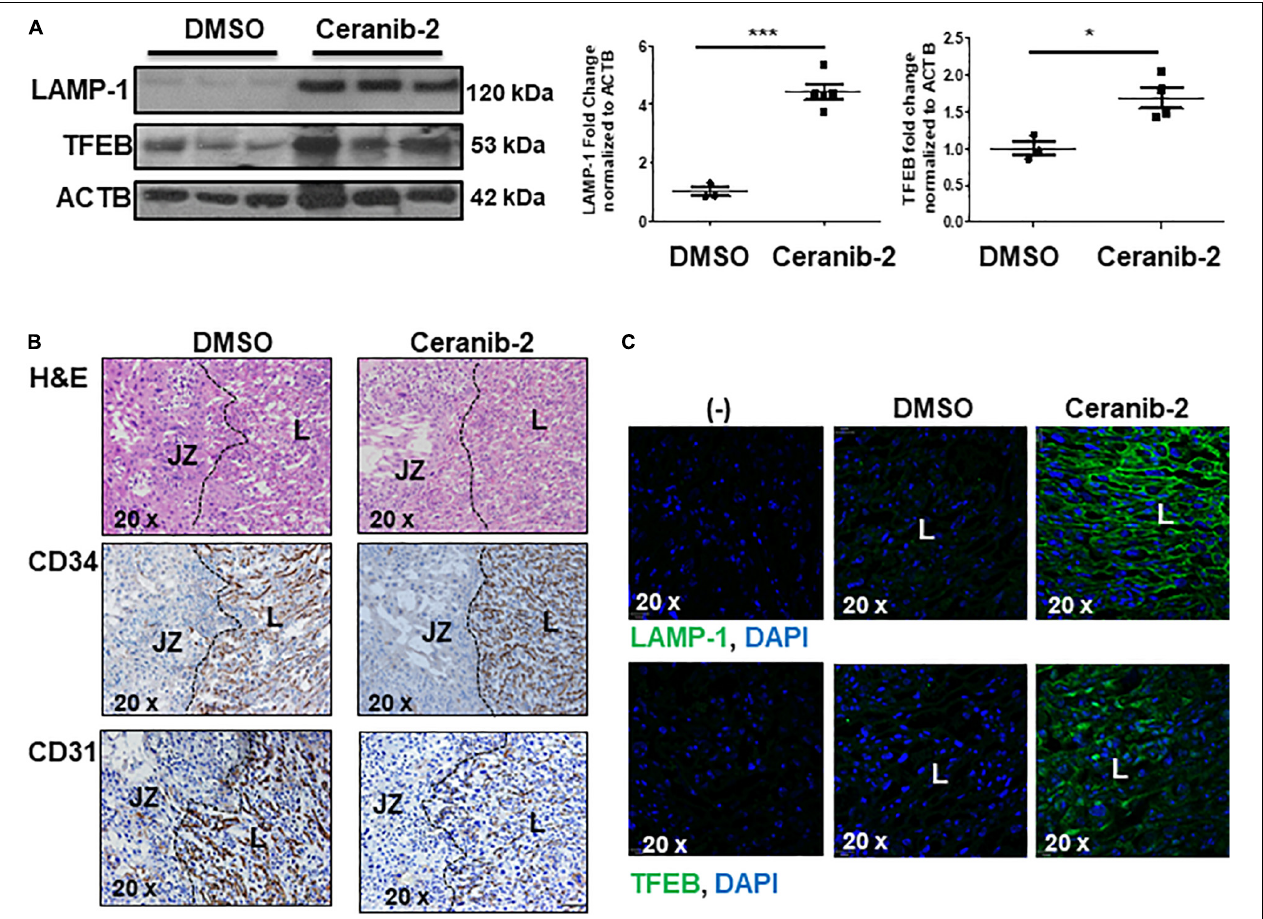
FIGURE 4 | Inhibition of acid ceramidase with Ceranib-2 in pregnant mice increases placental lysosomal biogenesis (A) Representative WB for LAMP-1 and TFEB and corresponding densitometry in placental lysates from CD1 mice injected with ceranib-2 or DMSO vehicle (data are expressed as mean ± SEM; DMSO, N = 3; Ceranib-2, N = 5 for LAMP-1 and 4 for TFEB; *** P < 0.001 and * P < 0.05 compared to DMSO vehicle control). (B) Hematoxylin and Eosin (H&E) staining (upper panel) and immunohistochemistry for CD34 (middle panel) and CD31 (lower panel) in placental sections from Ceranib-2 and DMSO-treated mice. S, spongiotrophoblast layer. L, labyrinthine layer. (C) Representative IF images for LAMP-1 (green) and TFEB (green) in placentae of mice injected with either ceranib-2 or DMSO. Nuclei were visualized with DAPI (blue). (–) Non-immune IgG negative